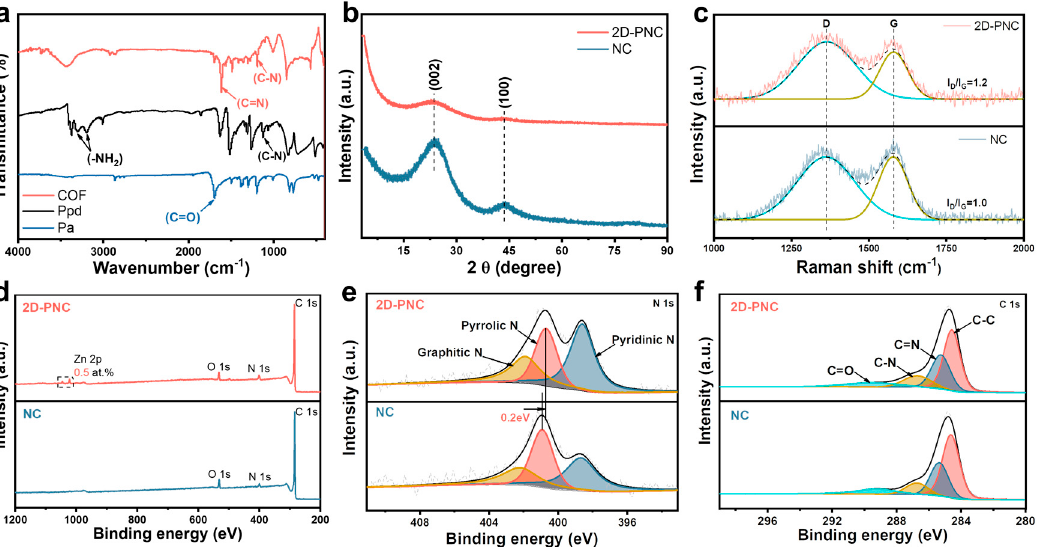
Figure 2. ( a ) FTIR of Pa-Ppd COF. ( b ) XRD pattern of 2D-PNC and NC. ( c ) Raman spectra of 2D- PNC and NC. ( d ) Typical XPS survey spectrum and corresponding ( e ) N 1s, ( f ) C 1s XPS spectra of the 2D-PNC and NC. 2D-PNC and